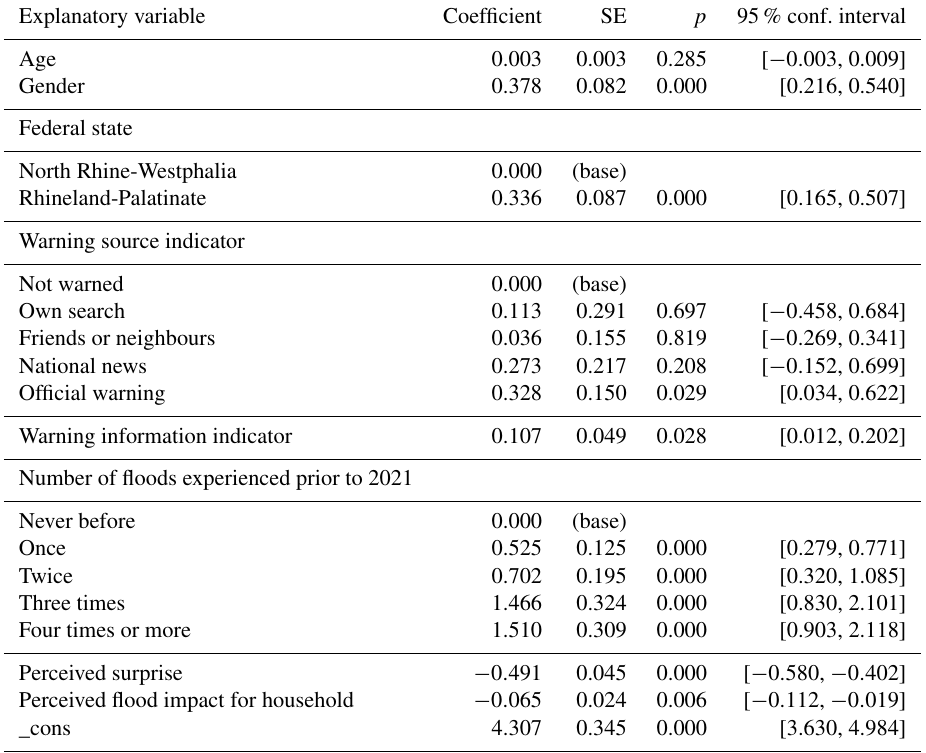
Table 4. Results of the linear regression model predicting respondents’ situational knowledge on protective behaviour (knowing what to do; n = 1097). All variable definitions, coding and summary statistics are provided in the Supplement, Table